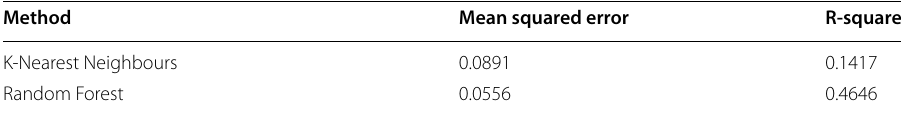
Table 2 Accuracy for three models